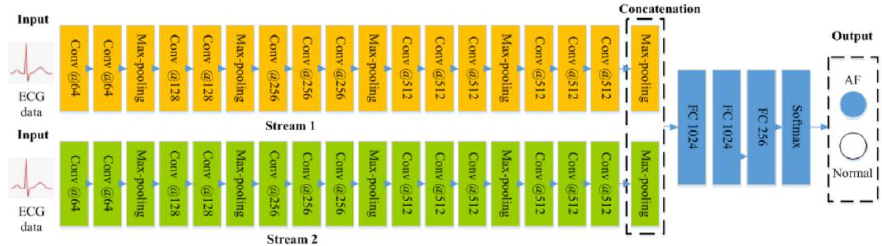
Figure 3. Example of two stream based convolutional neural networks.